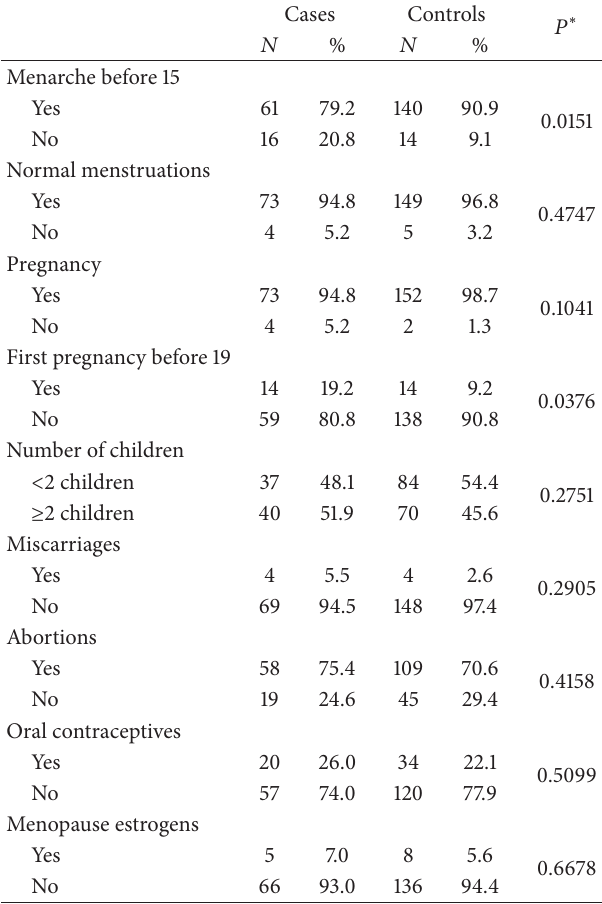
Table 3: Hormonal and reproductive characteristics of female examinees.